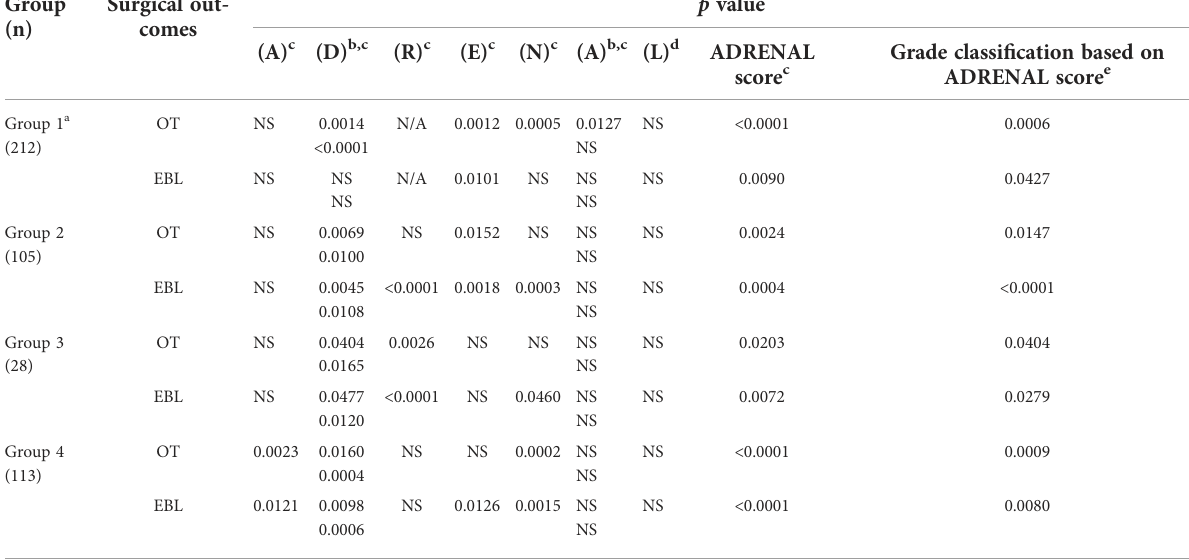
TABLE 5 Correlation analysis of each single components in ADRENAL score, ADRENAL score and a Grade classi fi cation verse OT and EBL. Group Surgical out- (n)